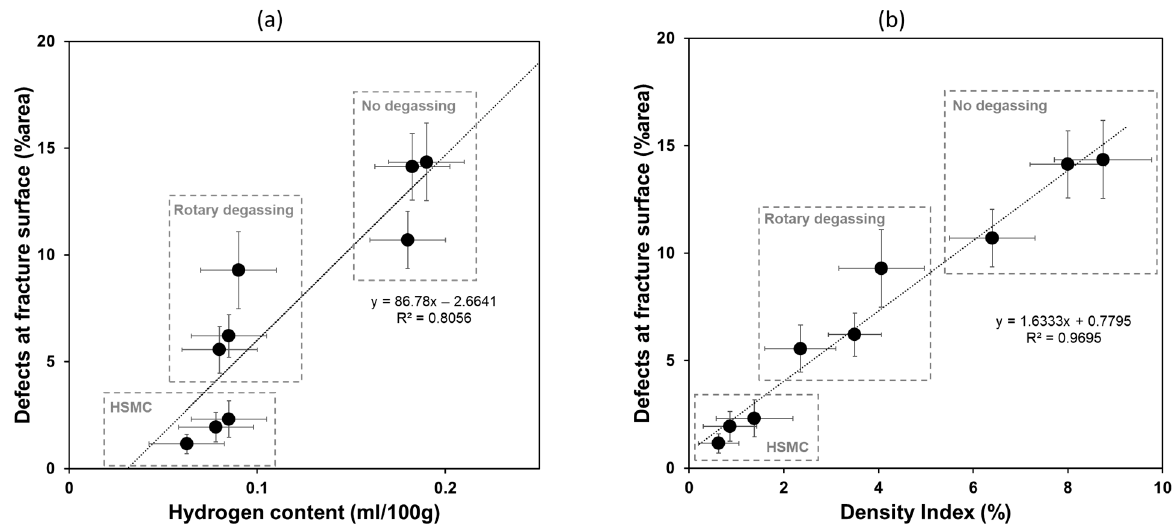
Figure 9. Area fraction of defects at the fracture surface of postmortem tensile bars versus the melt quality before and after degassing, evaluated by ( a ) hydrogen content and ( b ) Density Index. Adapted by combining data from results in a previous study [24].